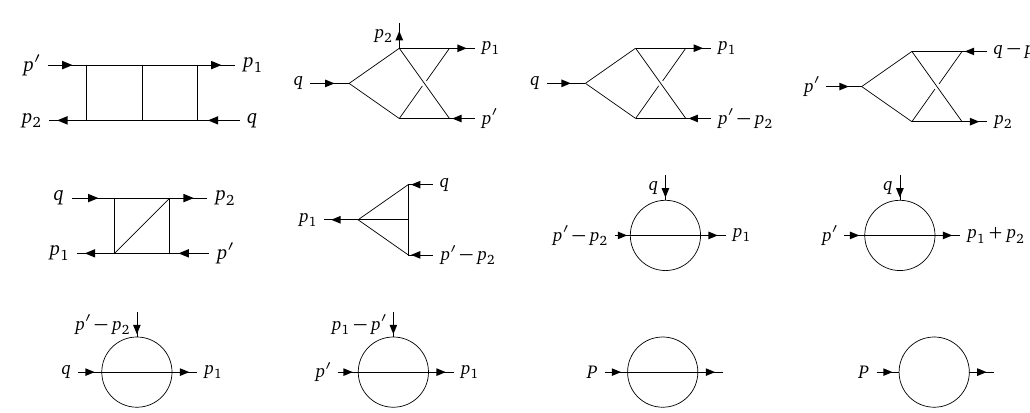
Figure 3: Complete set of master integrals for the two-loop